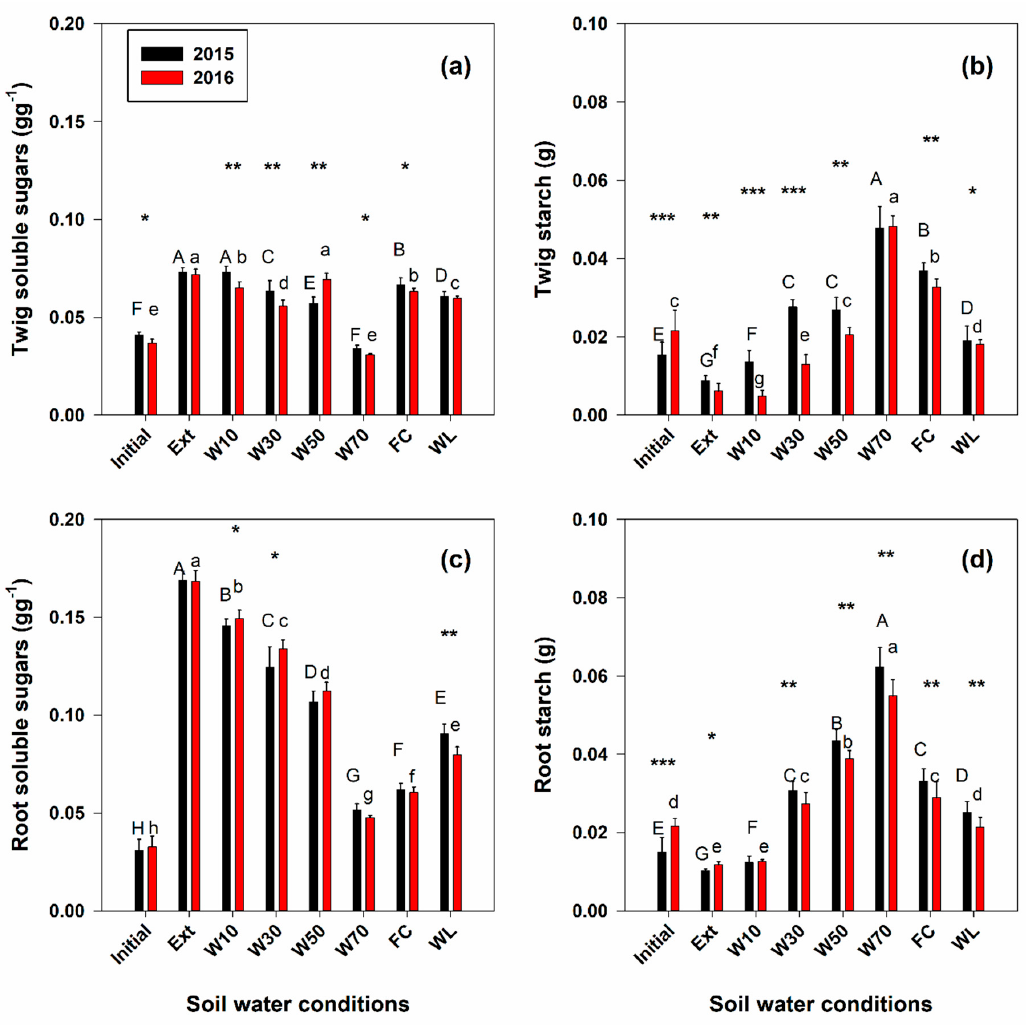
Figure 3. Soluble sugar (SS) and starch concentrations in twigs ( a , b ) and roots ( c , d ) for each of the water status treatments in 2015 (black bars) and 2016 (red bars). The treatments are Ext: extreme drought, W10: 10% of field capacity (FC), W30: 30% of FC, W50: 50% of FC, W70: 70% of FC, and WL: permanently waterlogged. Asterisks indicate a significantly different values (*, p < 0.05; **, p < 0.01; ***, p < 0.001) between 2015 and 2016. Different letters indicate significant differences between treatments in each year. The upper-case letter refers to 2015 and the lower-case letter refers to 2016.